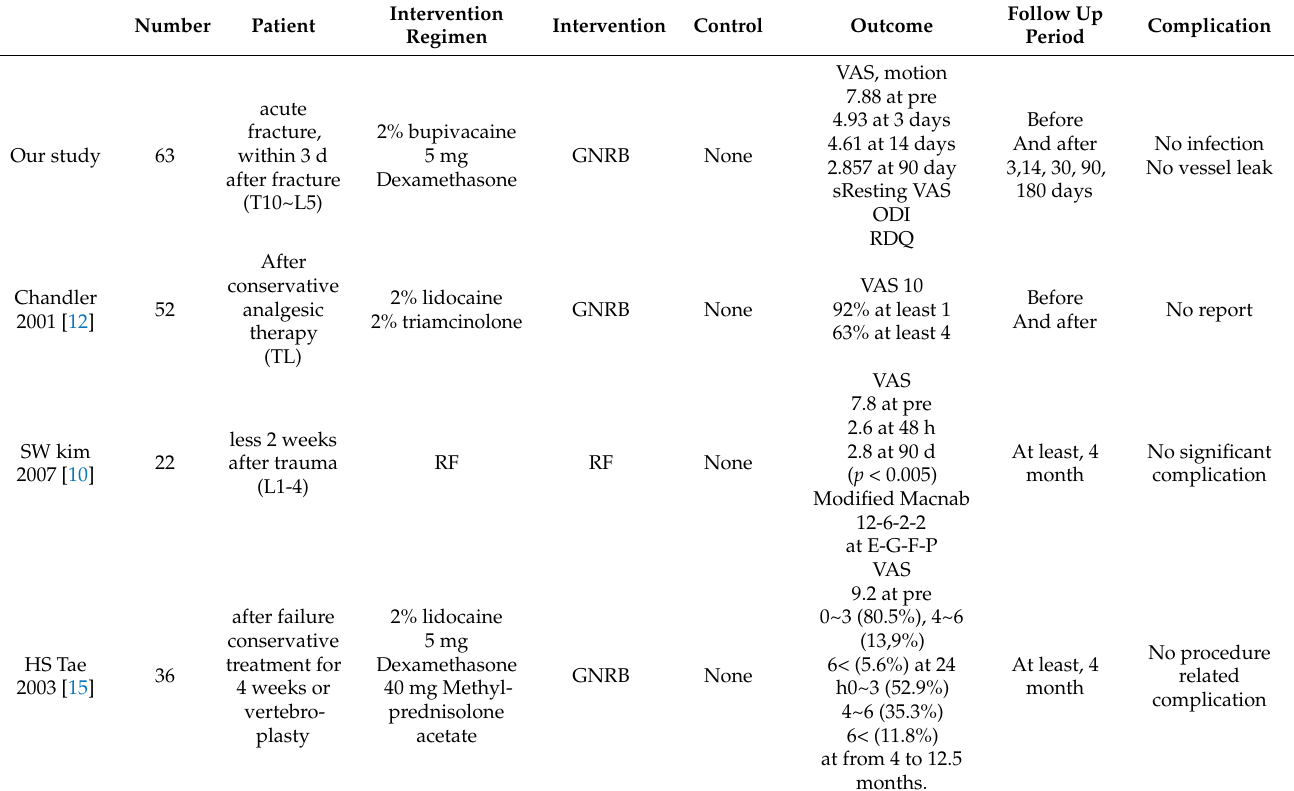
Table 4. Summarization of our study comparing with